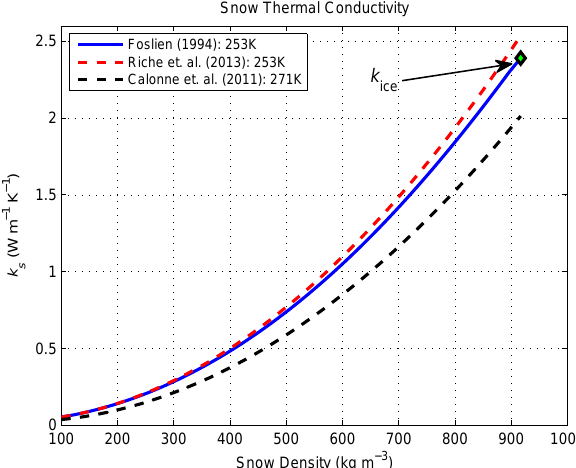
Figure 5. Thermal conductivity analytical prediction of Foslien (1994) vs. finite element predictions of Calonne et al. (2011) and Riche and Schneebeli